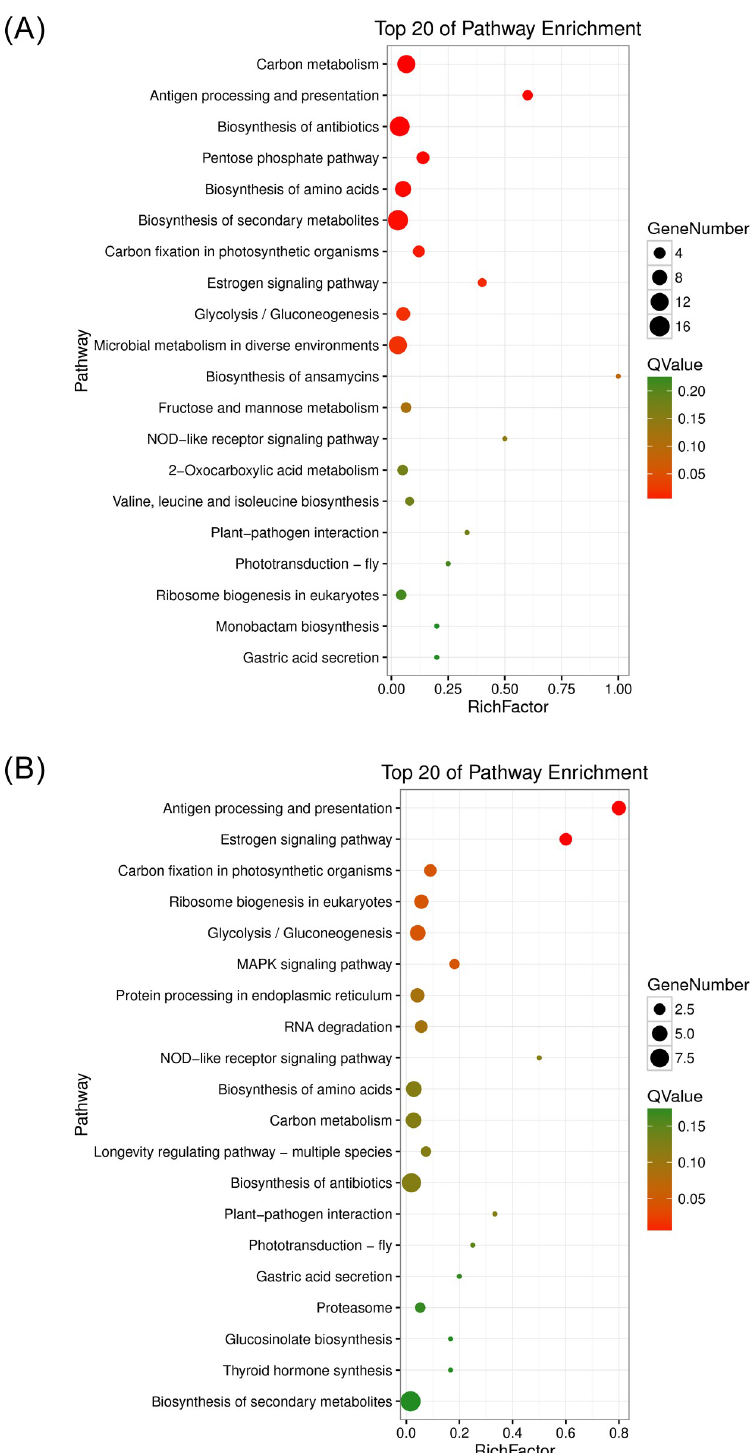
Fig 8. Intergroup KEGG enrichment bubble map. The Q value of the red bubble diameter is lower than that of the green bubble diameter. The bubble size is proportional to gene number. The x-axis shows the top 20 pathways in which the differentially genes expressed, and the y-axis represents rich factor. (A) CK-vs.-F comparison; (B) F-vs.-AF comparison.